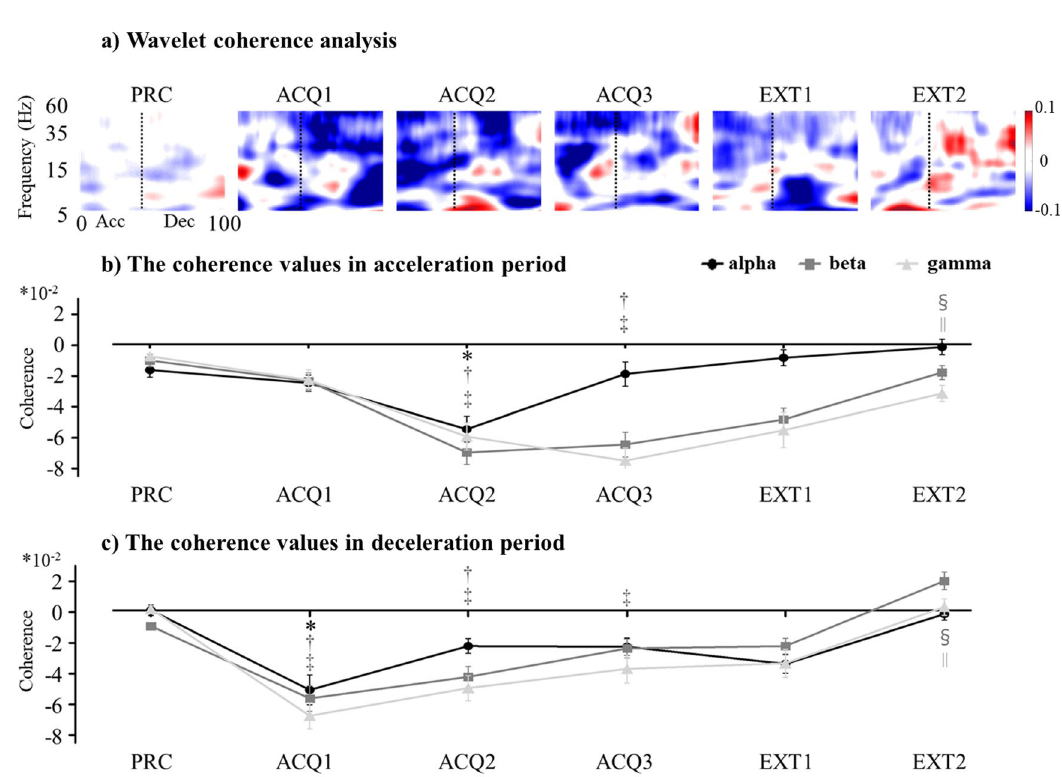
Figure 5. ( a ) Wavelet coherence analysis. The color bar on the right indicates the coherence value. Relative times (%) of the reaching movement are indicated on the X-axis and frequencies are illustrated on the Y-axis. Acc: Acceleration period. Dec: Deceleration period. ( b ) The coherence values in the acceleration period (ACC) (+ SEs) for the CS movements. ( c ) The coherence values in the deceleration period (DEC) (+ SEs) for the CS movements. PRC: practice phase. ACQ1–3: 1st, 2nd, and 3rd blocks of the acquisition phase. EXT1–2: 1st and 2nd blocks of the extinction phase. *Significant difference in α-bands between the practice and other phases ( p < 0.05). †Significant difference in β-bands between the practice and other phases ( p < 0.05). ‡Significant difference in γ-bands between the practice and other phases ( p < 0.05). §Significant difference in β-bands between the 3rd block of the acquisition phase and the other phases ( p < 0.05). ||Significant difference in γ-bands between the 3rd block of the acquisition phase and other phases ( p <